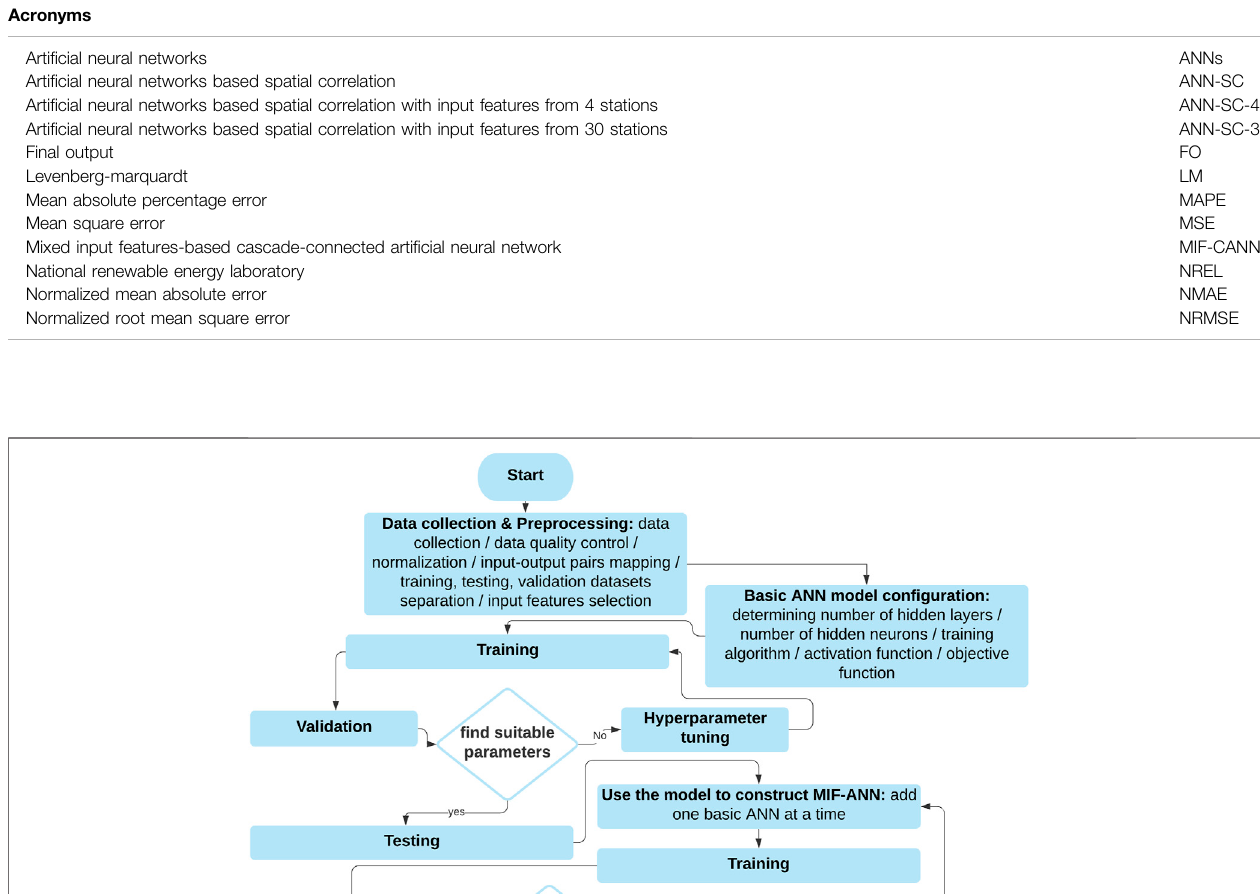
TABLE 1 | Summary of acronyms used in this paper.